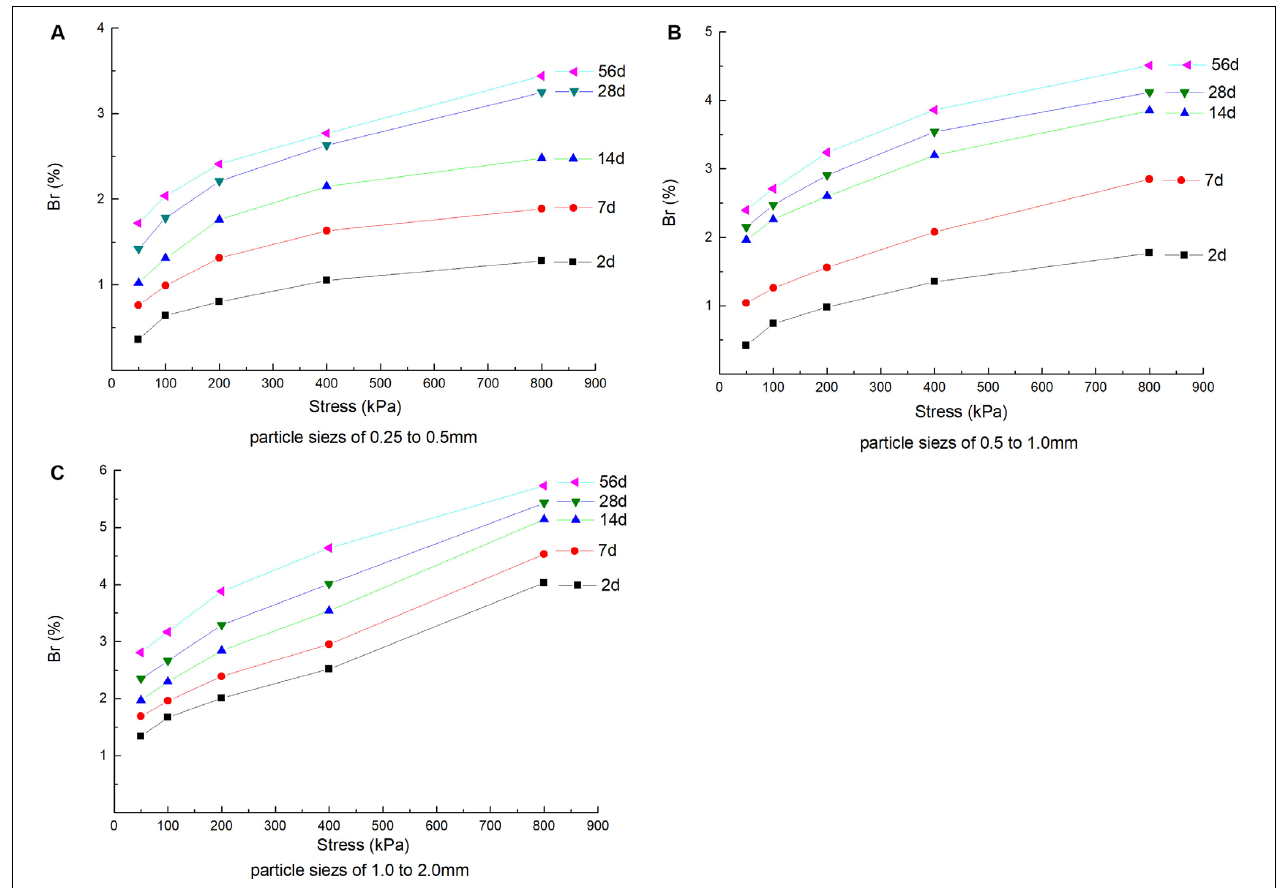
FIGURE 11 | Relative particle breakage rate-stress isochrones. (A) Particle sizes of 0.25–0.5 mm, (B) particle sizes of 0.5–1.0 mm, and (C) particle sizes of 1.0–2.0